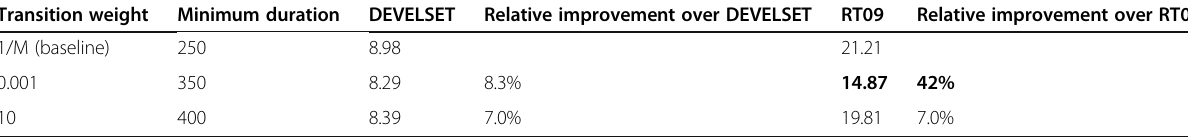
Table 3 SER for all the systems developed using a single channel. M is the number of active clusters at each iteration